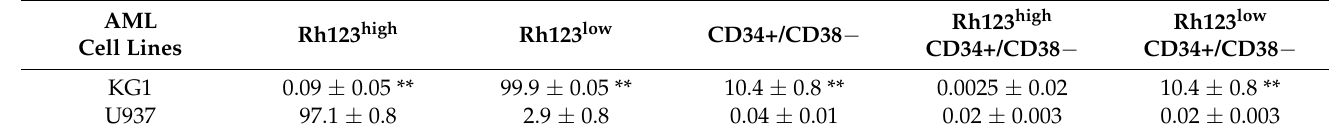
Table 2. LSC compartment identified by CD34 + CD38 − phenotype combined with the Rh123 exclu- sion assay in KG1 and U937 AML cell lines. Percentage of Rh123 low and Rh123 high cell compartments associated with or without CD34 and CD38 surface markers analyzed by flow cytometry. Means were compared between KG1 and U937 cells. ** p ≤